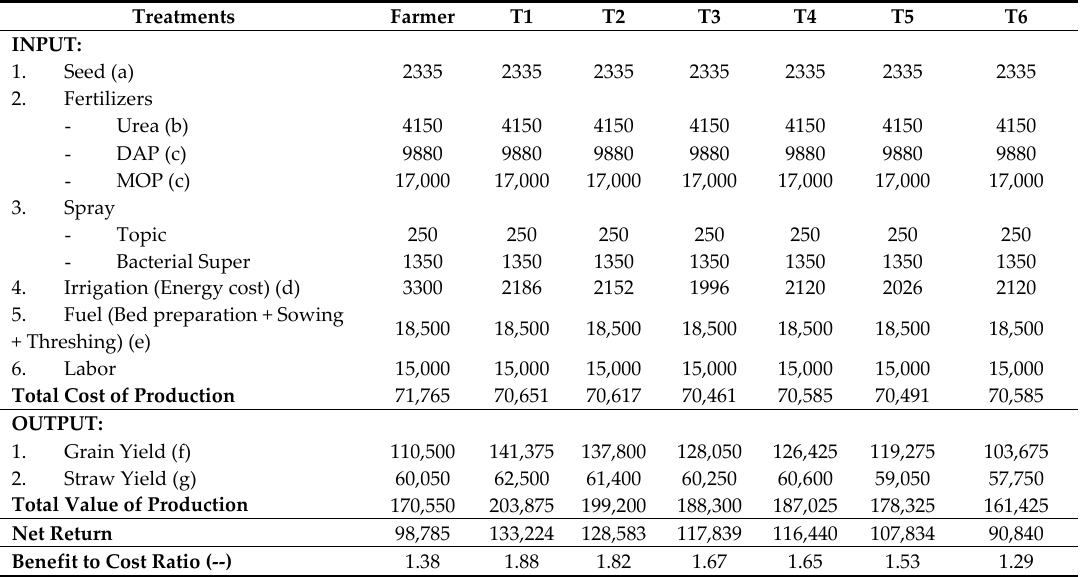
Table 5. Cost analysis (PKR) for wheat crop (per hectare) for Faisalabad, Pakistan, 2014–2015.